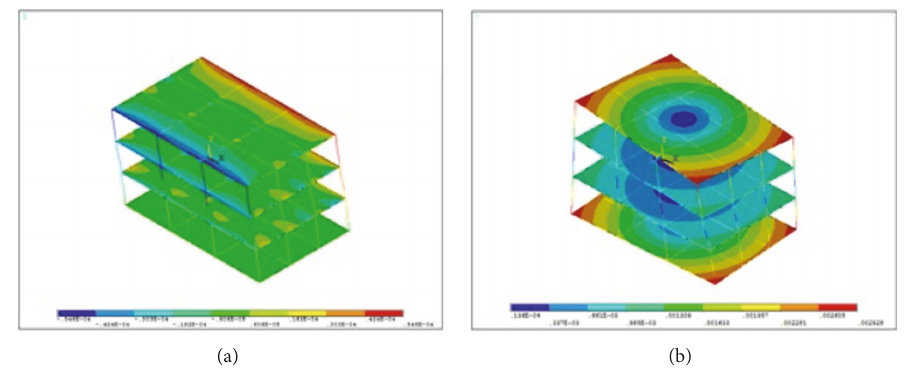
Figure 3: Building mode shapes at (a) 8.644 Hz and (b) 10.43 Hz.